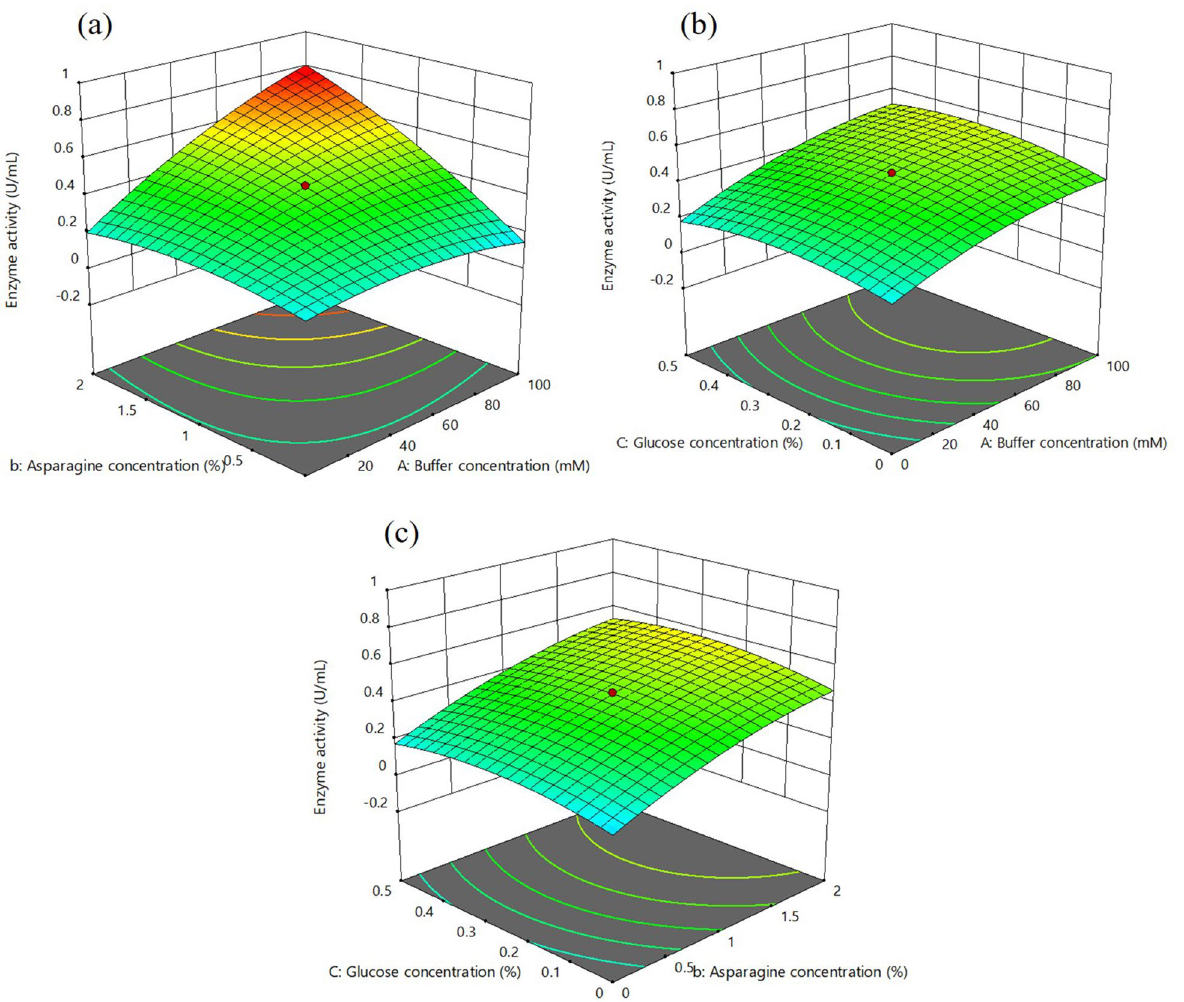
Fig. 2 Statistical optimization of production medium using RSM. Three-dimensional response surface plots showing the interactive effects of selective variable on L-ASNase activity, a L-asparagine (%, w/v) and buffer concentration (mM), b glucose (%, v/v) and buffer concentration (mM) and c L-asparagine (%, w/v), and glucose concentration (%, v/v)